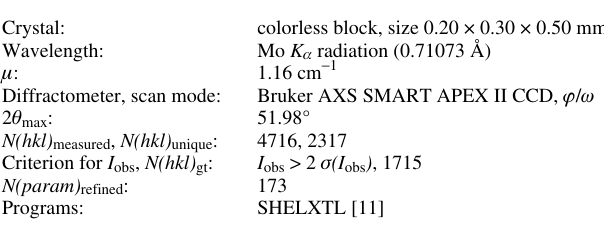
Table 2. Atomic coordinates and displacement parameters (in Å 2 ) . Atom Site y z U iso Crystal: